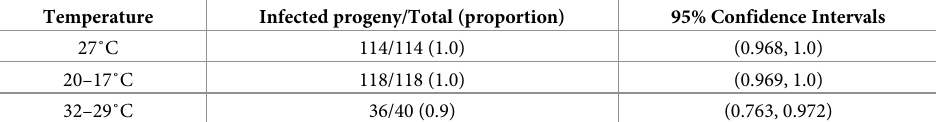
Table 1. Vertical transmission rates of c Eper1 at various temperature ranges. Proportion of infected offspring are presented along with 95% Confidence Intervals from Exact binomial